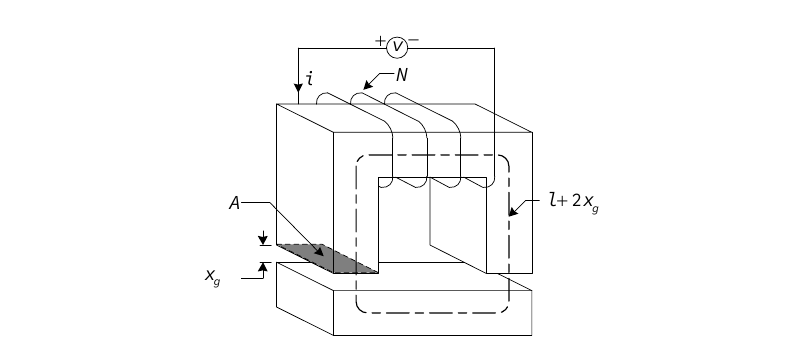
Figure 1. Simplified electromagnetic